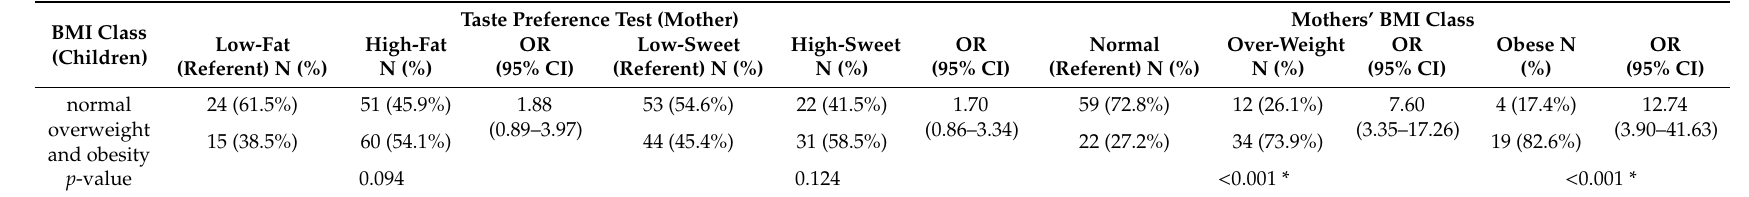
Table 4. Probability of o ff spring’s overweight and obesity according to the mother’s BMI and taste